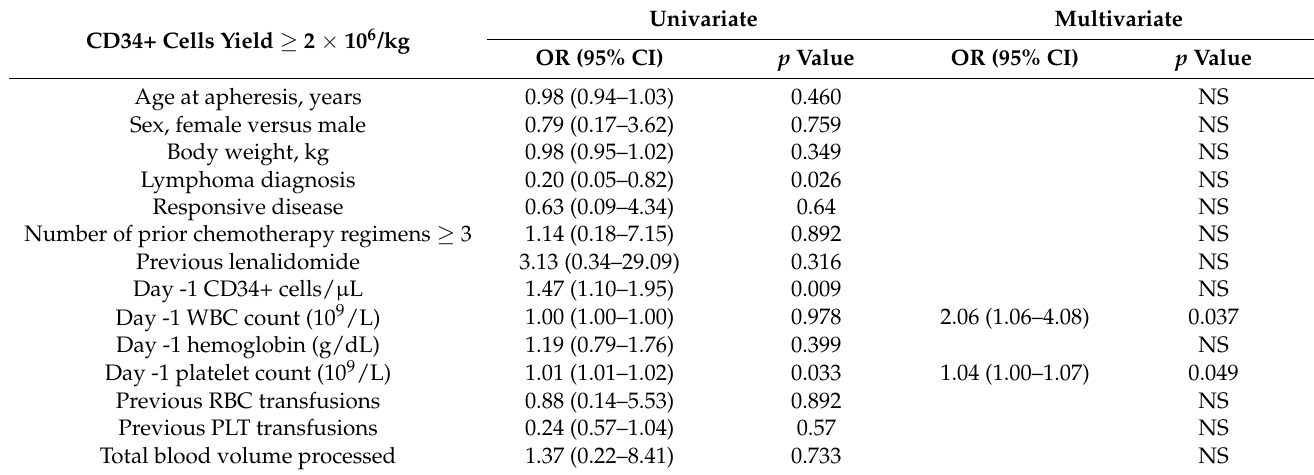
Table 3. Association between clinical and laboratory parameters and completion of the CD34+ cell dose at first apheresis. Results of univariate and multivariate analyses are